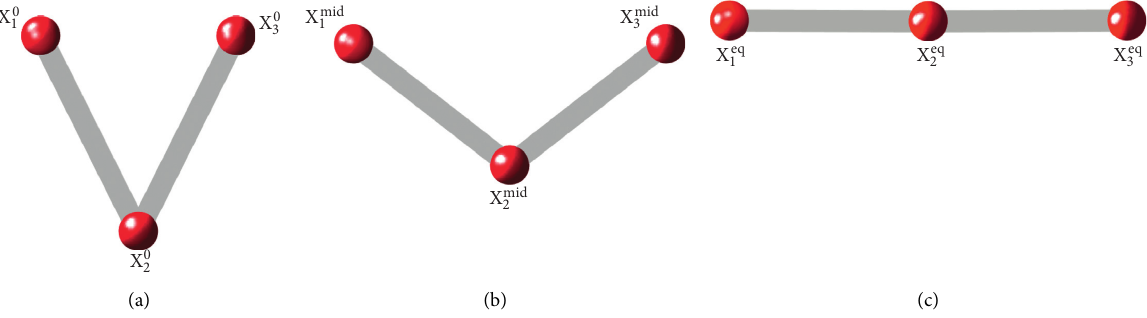
| X n − X n | < d ij for the i j